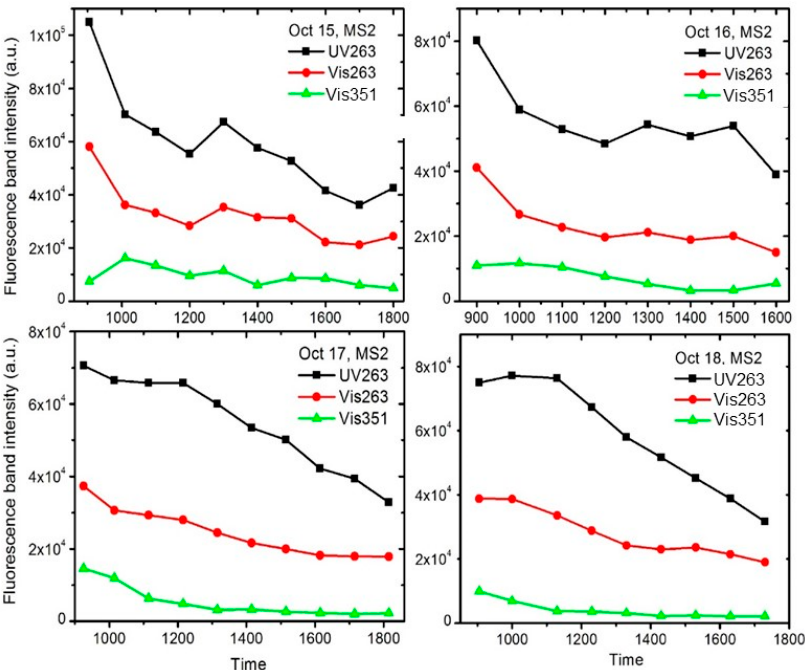
Figure 5. Changes in integrated fluorescence band intensities with time for MS2 aerosol on 15 October 2012 ( top left ), 16 October 2012 ( top right ), 17 October 2012 ( bottom left ), and 18 October 2012 ( bottom right